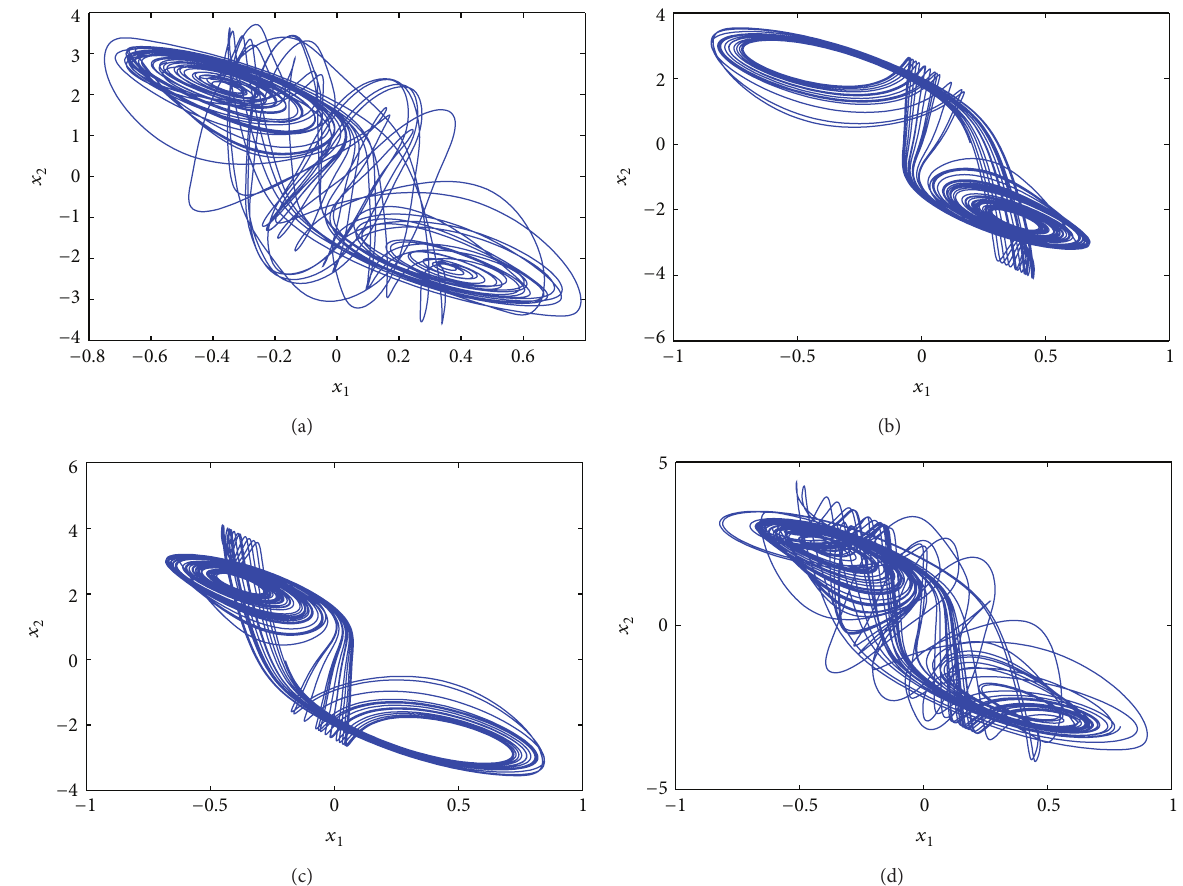
Figure 5: Different fully developed double-scroll chaotic attractors; (a) with 𝛼 = 0.87 and initial value [0.4, 0.6] 𝑇 ; (b) with 𝛼 = 0.93 and initial value [0.4, 0.6] 𝑇 ; (c) with 𝛼 = 0.93 and initial value [−0.4, −0.6] 𝑇 ; (d) with 𝛼 = 0.97 and initial value [0.4, 0.6] 𝑇 .